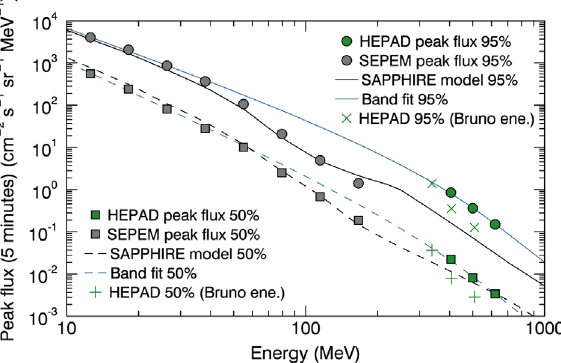
Fig. 6. Comparison of peak fl ux spectra for a two year mission at con fi dence levels 50% (squares) and 95% (circles). Green symbols show the results for HEPAD, grey symbols show the results for SEPEM data modeled similarly as the HEPAD data, and black lines show the results of the SAPPHIRE model. Blue lines show Band fi ts to HEPAD points and SEPEM points between 10 MeV and 50 MeV. Green plus signs and crosses show the HEPAD results converted to energies given by Bruno (2017); see the text for